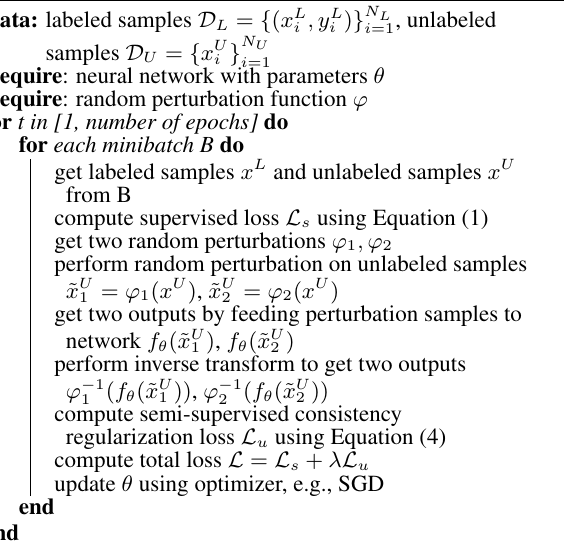
Algorithm 1: Mini-batch training for semi-supervised se- mantic segmentation